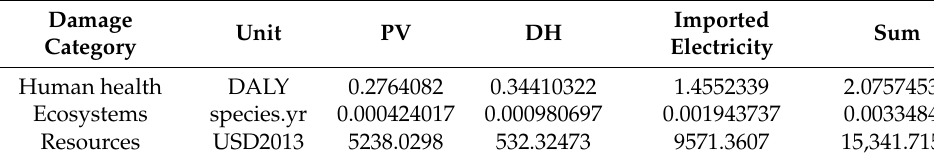
Figure 8. Midpoint overview from the Smaragd buildings energy system. Table 5. Damage